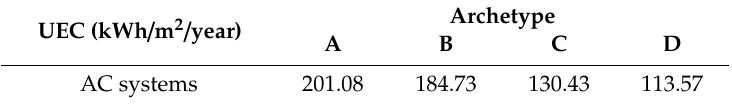
Table 2. Average unit energy consumption of AC systems for di ff erent residential dwellings in Kuwait.